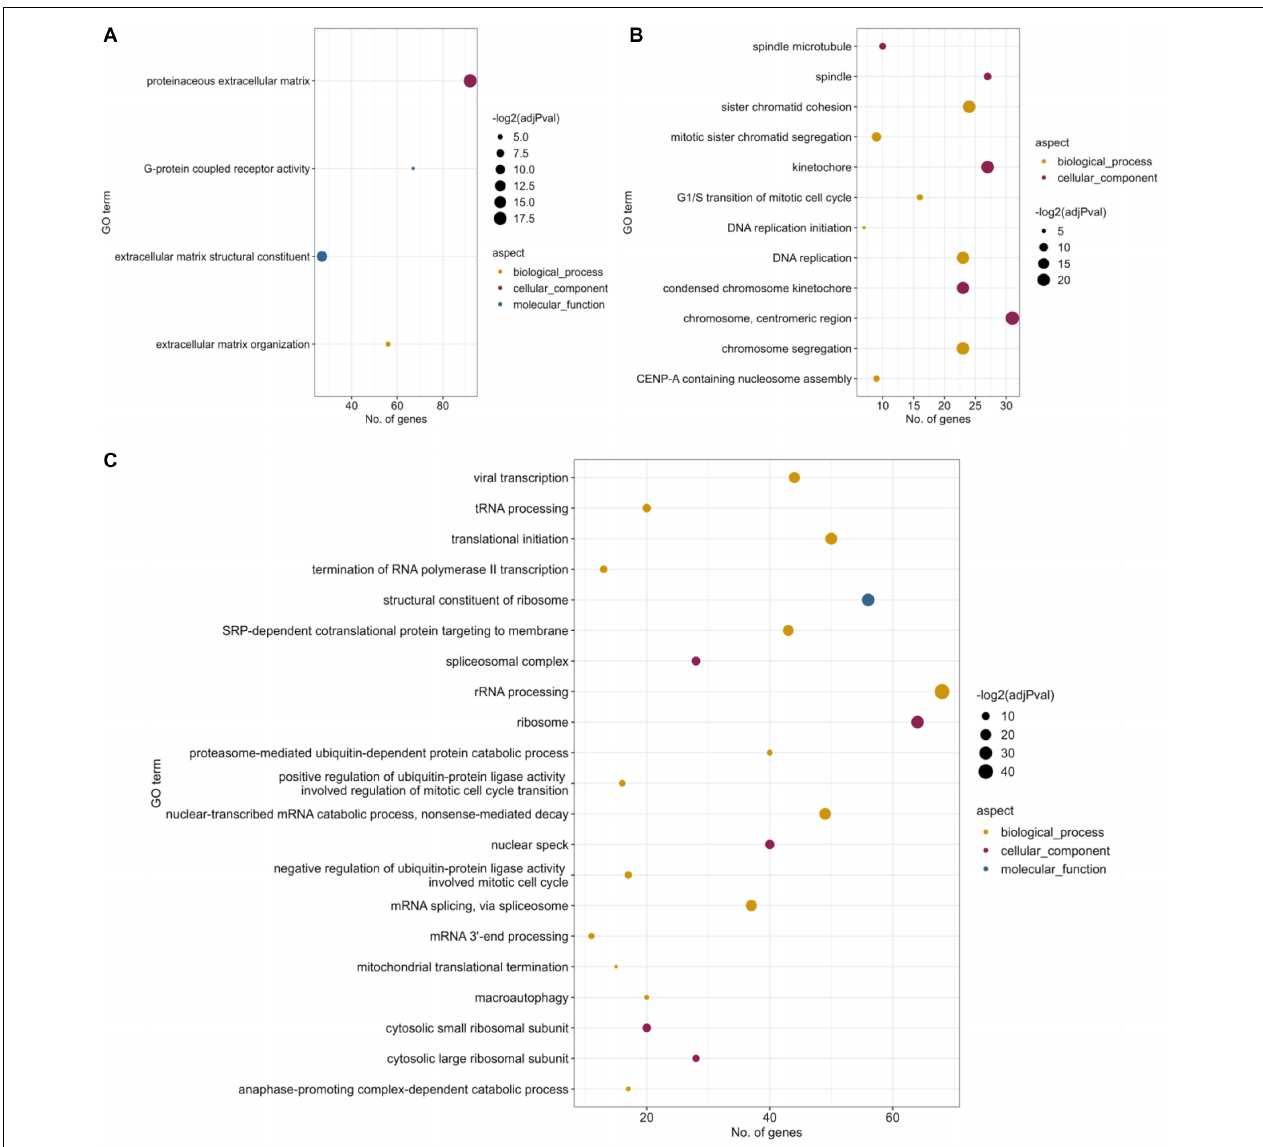
FIGURE 2 | Functional enrichment results for differential gene expression. Significantly enriched (FDR < 0.05) Gene Ontology terms for (A) Patient-RPE vs. Control-RPE contrast, filtering genes that are DE between patient and control fibroblasts. (B) Patient-RPE vs. Patient-fibroblasts, filtering genes that are DE in the control contrast, and (C) Control-RPE vs. Control-fibroblasts, filtering genes that are DE in the disease contrast. Dot size indicates significance of the Fisher’s Exact Test [–log(adj p value)], x -axis position indicates the number of DE genes that are annotated for each significant GO term, and dot color indicates the GO aspect under which the term is